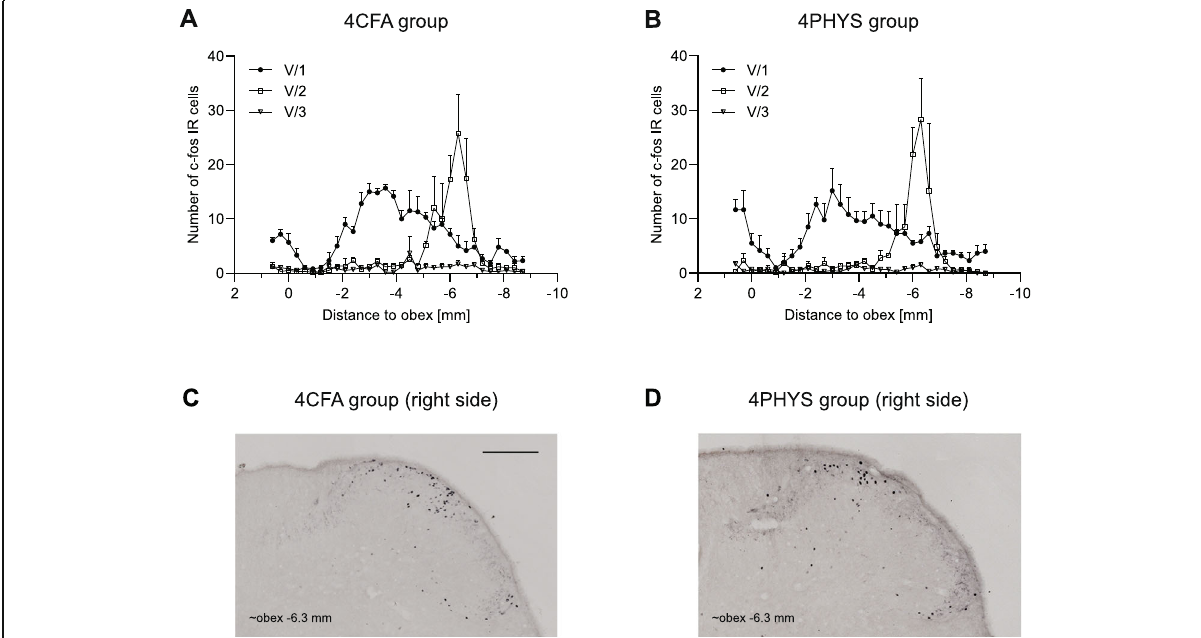
Fig. 4 Diagrams illustrate the number of c-Fos positive neurons (mean + SEM) 4 h after CFA a or saline b treatment. Representative photomicrographs of the dorsal horns in 4CFA c , 4PHYS d . Scale bar: 200 μ m. Cells were displayed according to somatotopic area of V/1, V/2, V/3 nerve. No difference was seen between 4CFA a and 4PHYS b